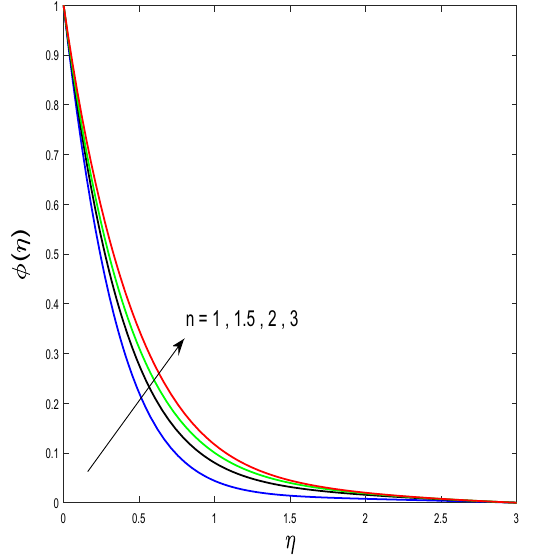
Figure 15. Plot of φ for n .